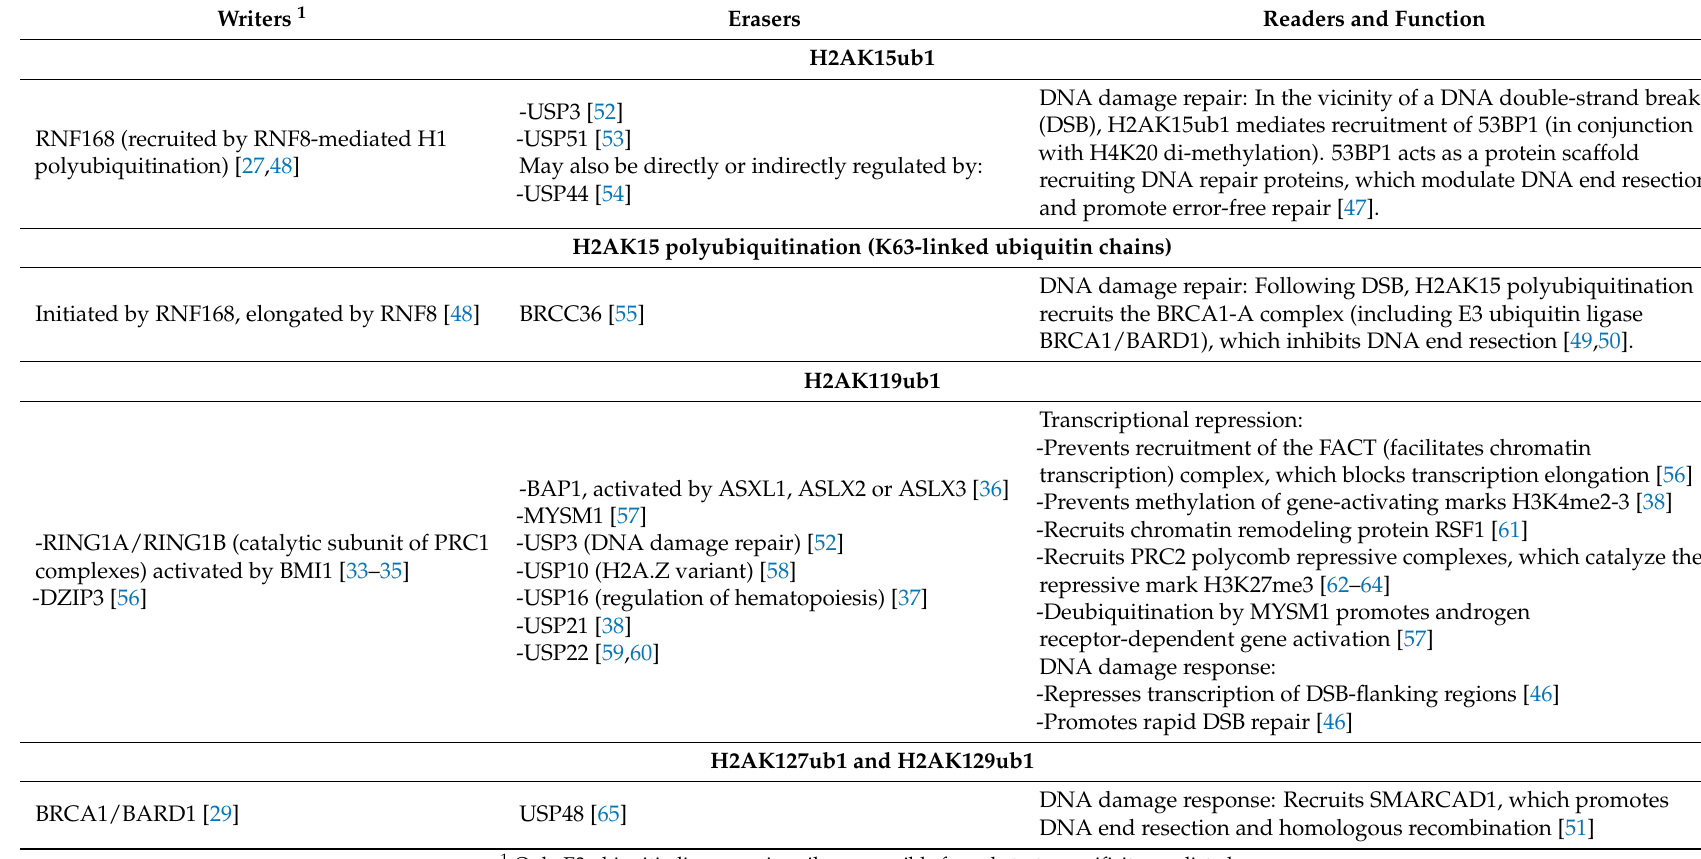
DNA damage response: Recruits SMARCAD1, which promotes DNA end resection and homologous recombination